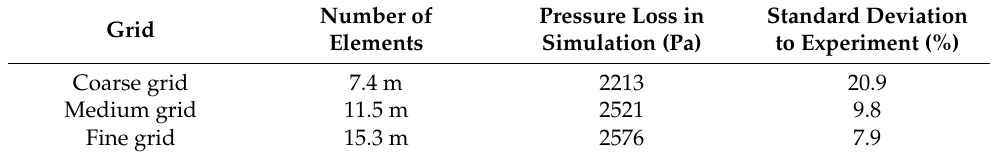
Table 2. A comparison between the simulated and experimental pressure loss of the three